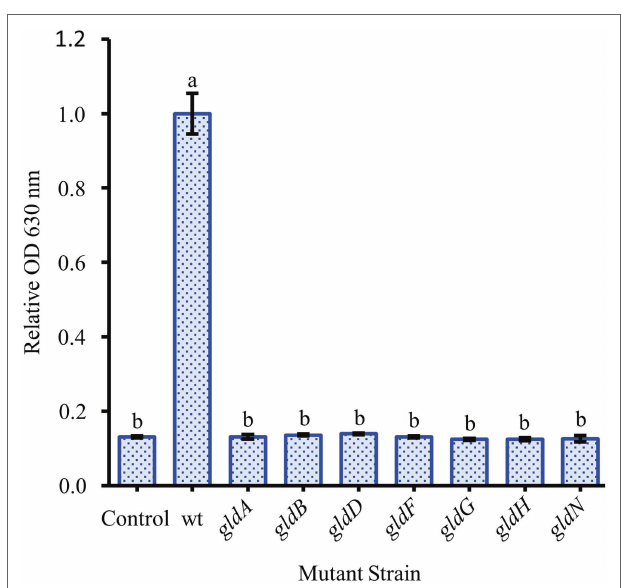
FIGURE 4 | Effect of loss of motility on biofilm formation is consistent across many specific gene knockouts. Biofilm formation was determined for strains with knockouts in genes originally identified by the loss of gliding motility. The specific loss of function mutants were: gldA : UW102-146; gldB : UW102-103; gldD : UW102-97; gldF : UW102-77; gldG : UW102-75; gldH : UW102-52; and gldN : UW102-33. Results are reported as relative OD values (averages of at least four replicates; normalized to the wild type). Error bars indicate 95% CI. Different letters above the error bars represent different significance groups (one-way ANOVA followed by Tukey test, value of p =